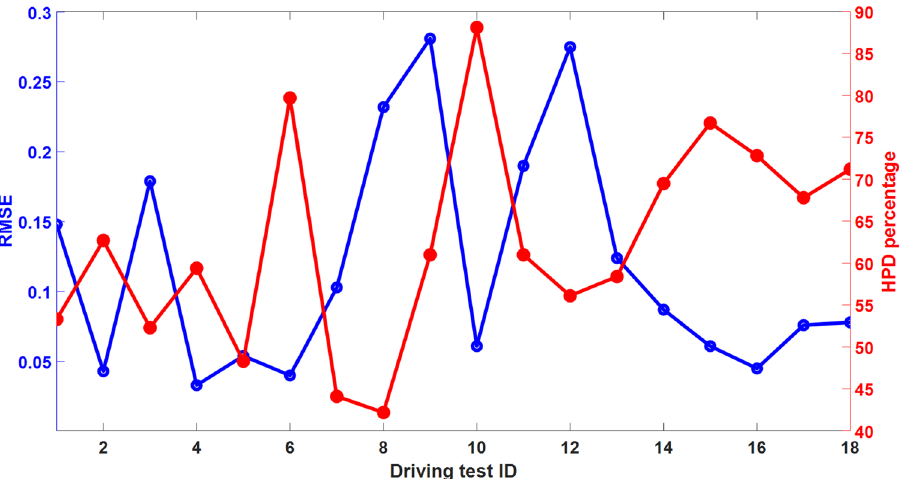
Figure 10. RMSE and HPD percentage metrics to evaluate the performance of the proposed encoding– decoding framework. The average RMSE and average HPD percentage across different driving tests are 0.117 and 62.5%, respectively.